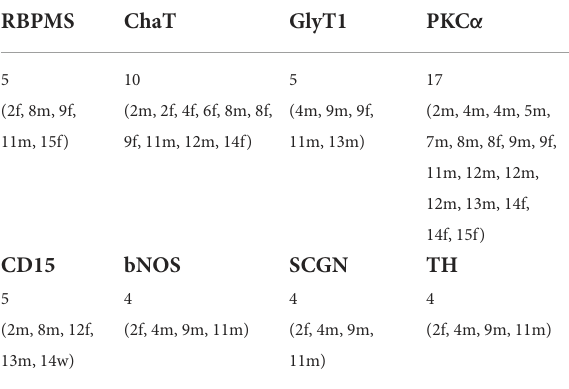
TABLE 2 Number of animals used for immunostaining (age and sex in